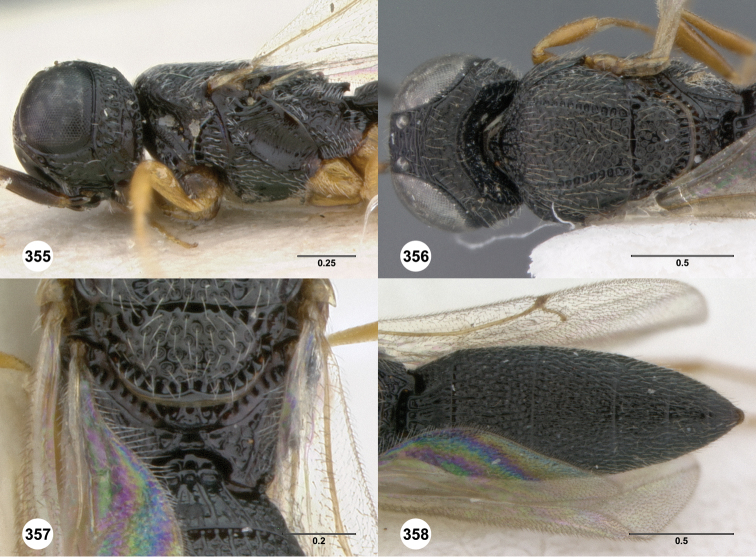
Oxyscelio stringerae sp. n., holotype female (OSUC 148369) 355 Head and mesosoma, lateral view 356 Head and mesosoma, dorsal view. Paratype female (368219) 357 Propodeum, posterodorsal view 358 Metasoma, dorsal view. Morphbank95